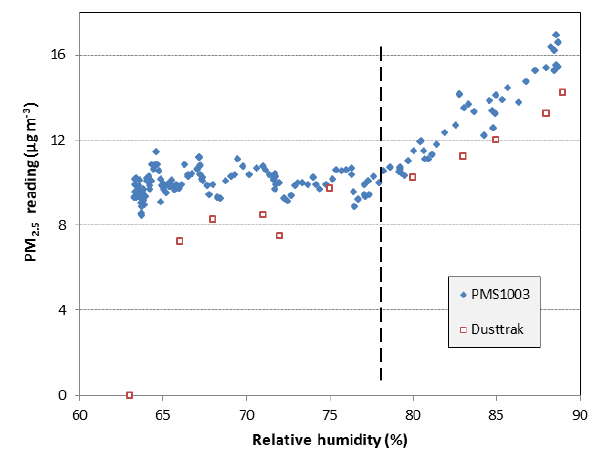
Figure 2. The PM 2 . 5 concentration reported by the PMS1003 and the DustTrak as the relative humidity was increased in the labora- tory chamber.